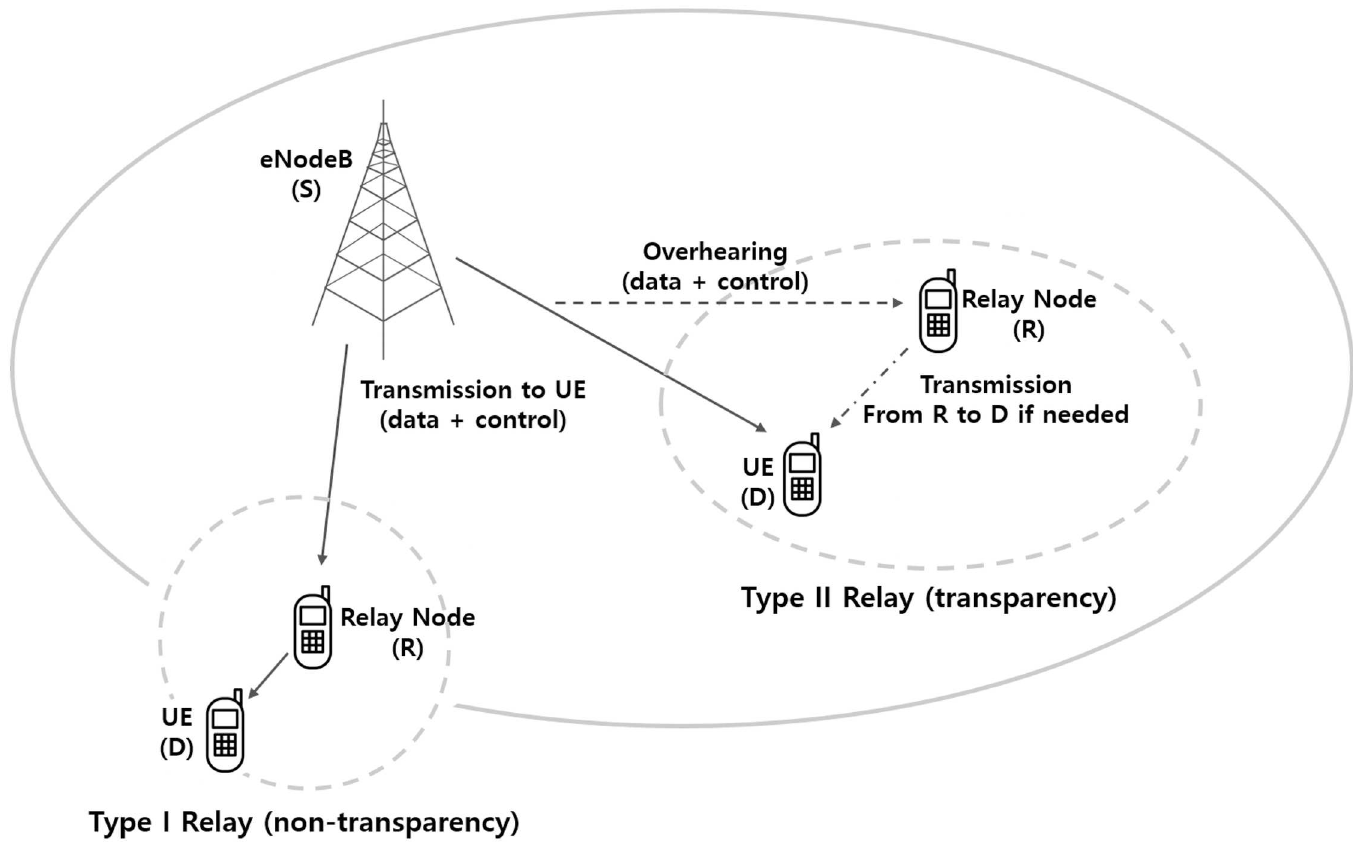
Fig 1. Example of Type I and Type II